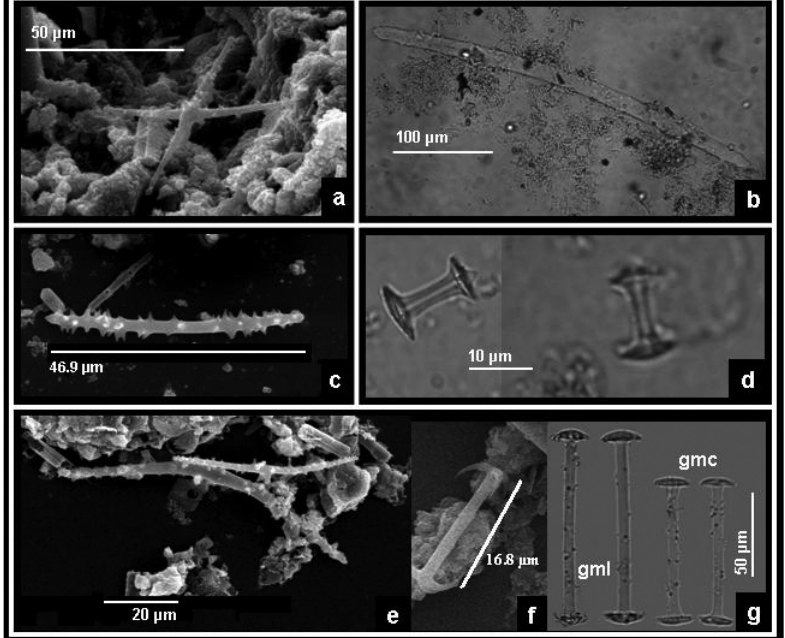
Fig. 4. Scanning Electron Microscope images (a, c, e, f) and Optical Microscope picture (b, d, g) of the sponge spicules found in the rocks of the Cemitério paleolake. a. Dosilia pydanieli Volkmer-Ribeiro (1992): a. microsclere; b, c. Radiospongilla amazonensis Volkmer-Ribeiro and Maciel (1983): b. megasclere, c. gemmosclere; d. Trochospongilla variabilis Bonetto and Ezcurra de Drago (1973): gemmoscleres; e, f, g. Corvoheteromeyenia australis (Bonetto and Ezcurra de Drago 1966): e. spiny oxea microscleres, f. chela microsclere, g. long (gml) and short (gmc)